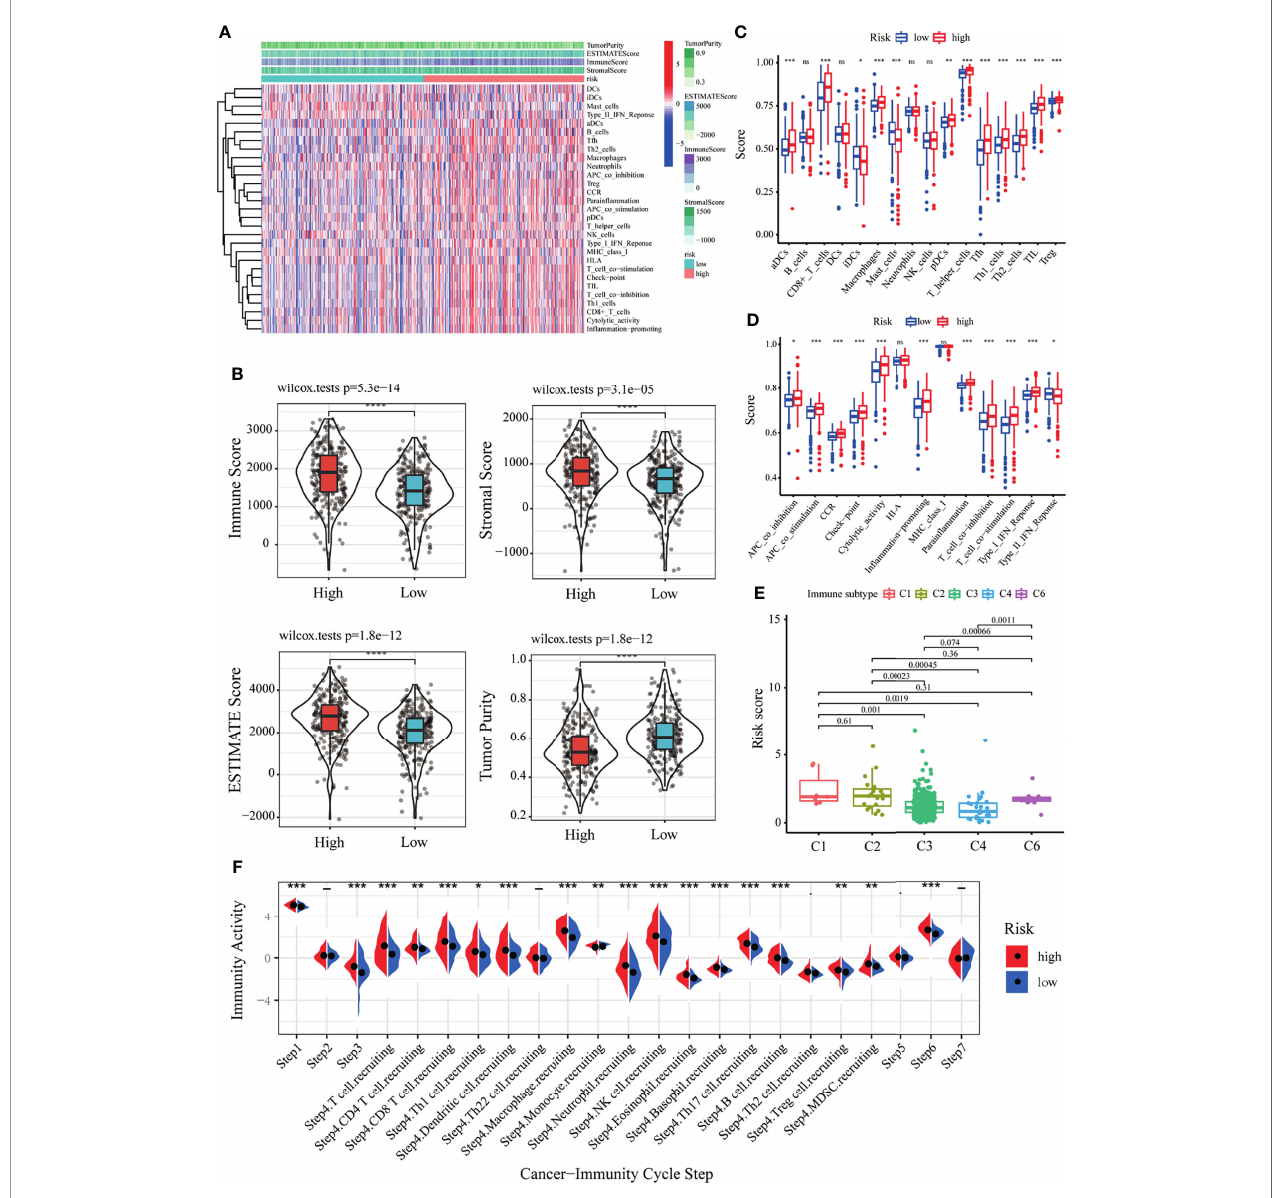
FIGURE 7 | Correlation of the lactate-related prognostic signature (LRPS) with the immune landscape of patients with kidney renal clear cell carcinoma (KIRC). (A) Enrichment levels of immune-related cells and types between the low- and high-risk groups. (B) Violin plot showing the differences in the immune score, stromal score, ESTIMATE score, and tumor purity between the low- and high-risk groups. (C) Correlation between the risk score and immune subtypes. (D) Differences in the 16 immune cells between the low- and high-risk groups. (E) Differences in the 13 immune-related functions between the low- and high-risk groups. (F) The difference of the abundance of antitumor immune cells between low- and high-risk groups. * p < 0.05, ** p < 0.01, *** p < 0.001, **** p < 0.0001. ns , not signi fi